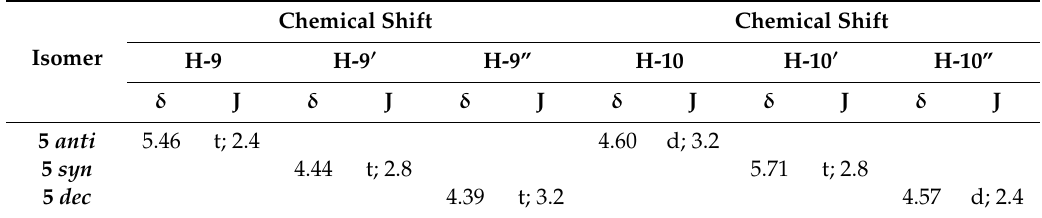
Table 1. The distinguishing between the isomers 5 anti , 5 syn, and 5 dec using chemical shifts. Chemical Shift Chemical Isomer